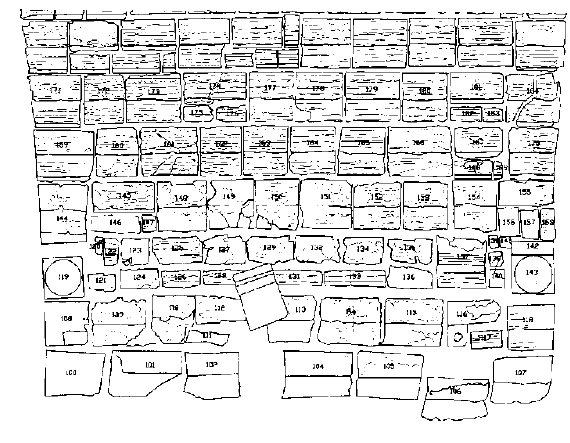
Figure 9. Photogrammetry of the Cais das Colunas, Lisbon Detailed restitution made after the dismantling (Genin, 1997).